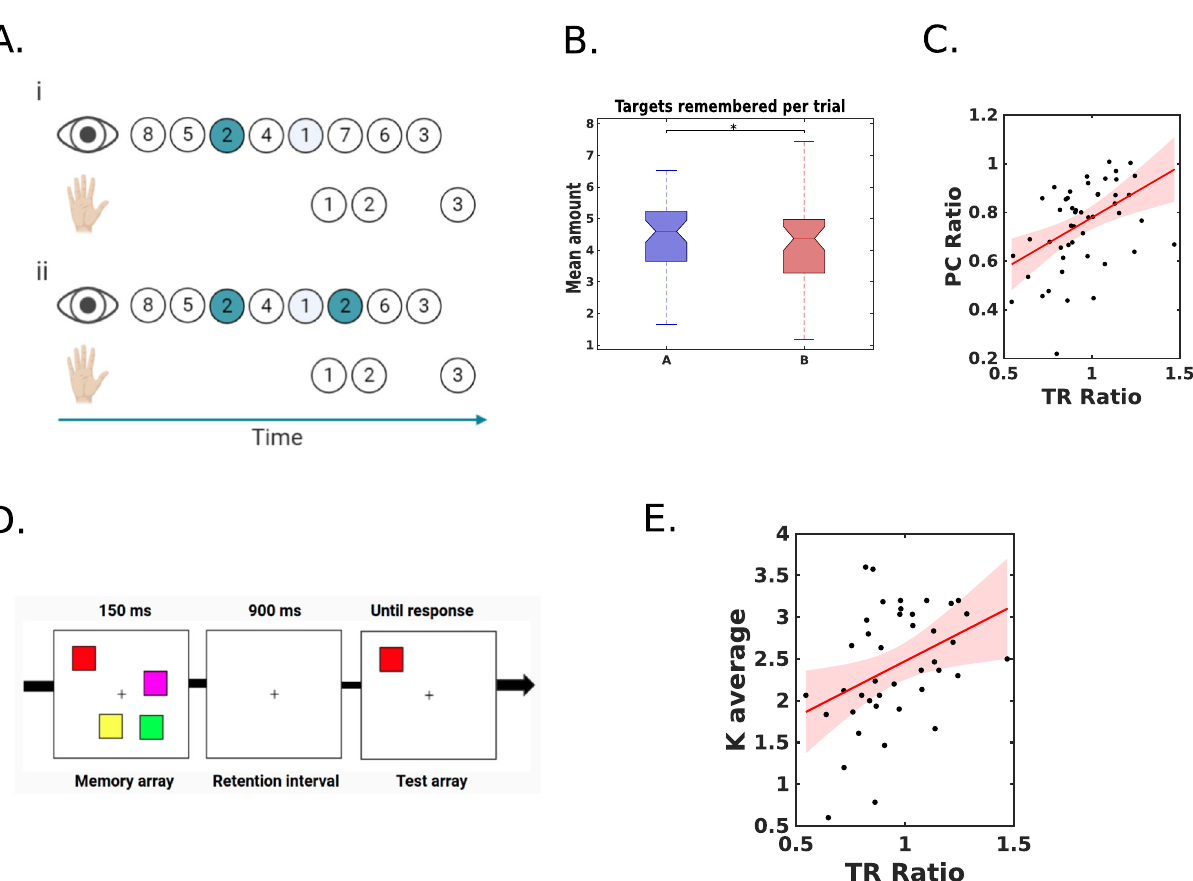
Figure 4. ( A ) Diagram for identifying targets remembered. In ( A.i ) the target “2” is remembered as it was not looked right before reaching it with the cursor, while in ( A.ii ) the target “2” was not remembered as it was seen again right before reaching it with the cursor ( B ) Boxplots for the mean amount of Targets Remembered (TR) for each subject in both parts (TMT-A and TMT-B) (C) Correlation between the PC Ratio (PC-B/PC-A) and the TR Ratio (Targets Remembered in B/ Targets Remembered in A). ( D ) Experimental design of the Change Detection Task. Memory array: 4 or 6 coloured squares were shown on-screen during 150 ms, retention interval: only fixation cross through 900 ms, Test array: A single square appeared on screen with same colour and location for consistent types of trials and difference in one or both characteristics for inconsistent ones. ( E ) Correlation between Visual Working Memory Capacity (K average ) and the TR